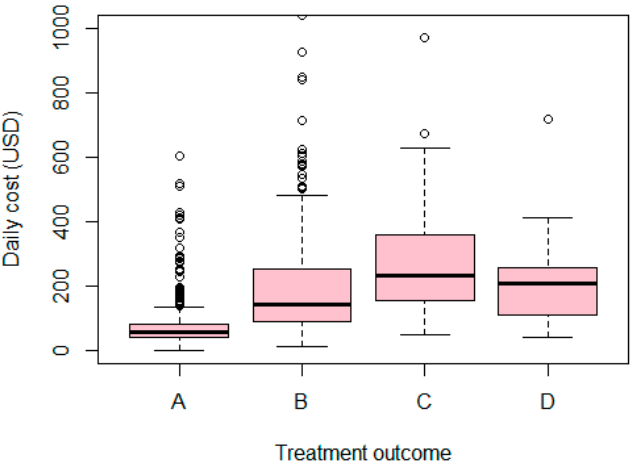
Figure 3. Treatment outcomes in relation to average daily cost. Treatment outcomes. A—Full recovery; B—Partial recovery; C—Stopped in middle; D—Unsuccessful treatment, including mortality.